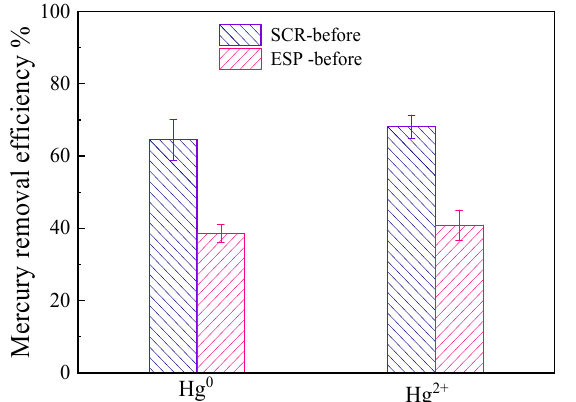
Figure 12. The effect of evaporative desulfurization wastewater at different positions on Hg removal efficiency.